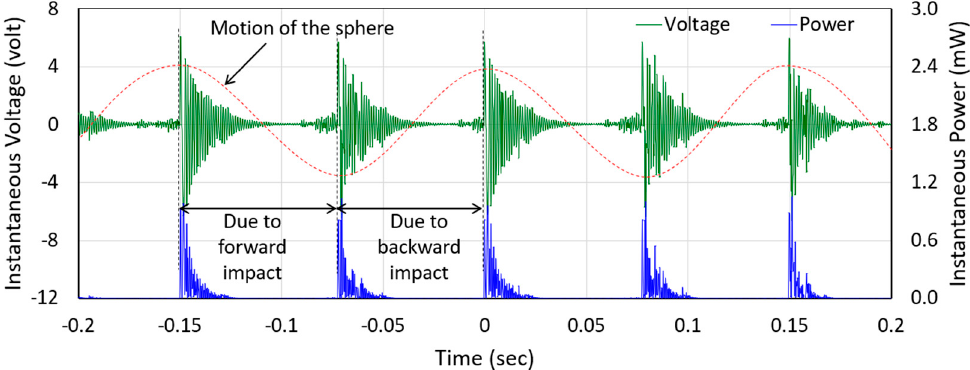
Figure 7. Instantaneous voltage and power waveforms measured across the 40 k Ω optimum load resistance of the piezoelectric transducer during the human-limb motion test.